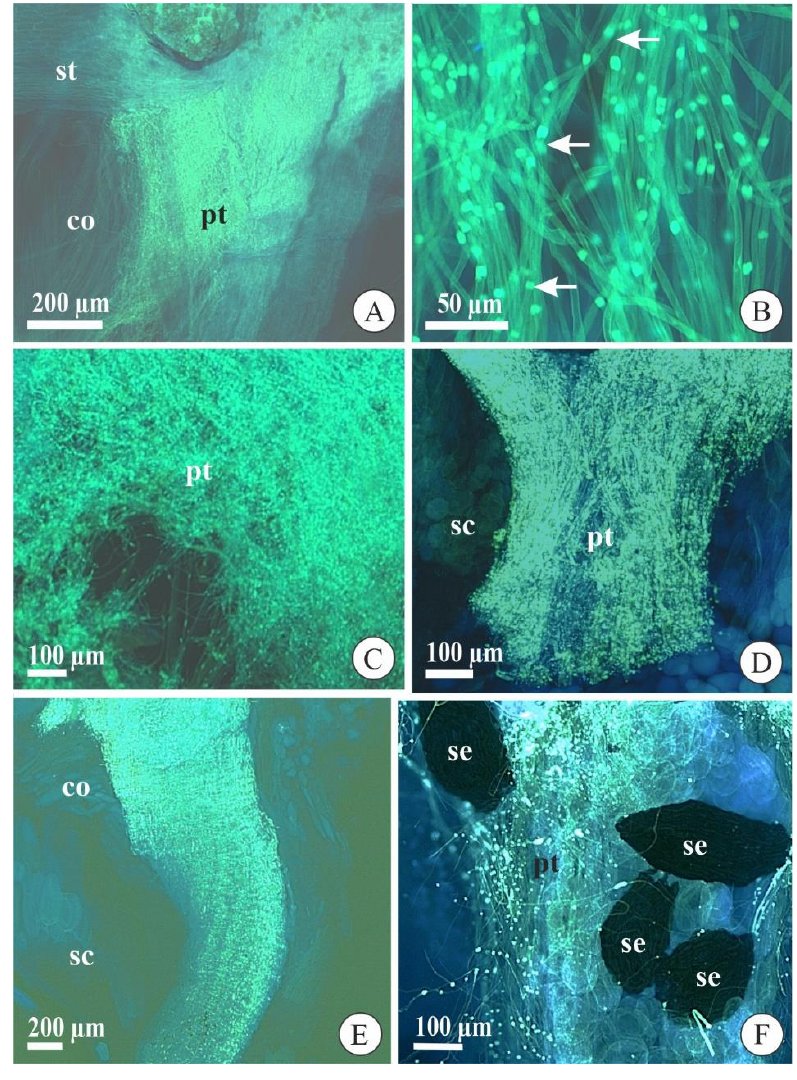
Figure 2. Pollen grain germination and pollen tube growth in flowers and fruits of Acianthera fabiobarrosii ( A , C , E ) and A. johannensis ( B , D , F ) observed with an epifluorescence microscope after cross-pollination. ( A , B ) Pollen tubes growing in the stylar canal inside the column (7 days after pollination-DAP). In B, observe the callose plugs regularly arranged along the length of the tube (arrows). ( C ) Pollen tubes reaching the ovary (10 DAP). ( D ) Pollen tubes in the seed chamber (38 DAP). ( E ) General view of pollen tubes in the column and seed chamber in a fruit (120 DAP). ( F ) Pollen tubes near the seeds with embryo in mature fruit (90 DAP). co, column. pt, pollen tube. sc, seed chamber. se, seed. st, stigmatic cavity.